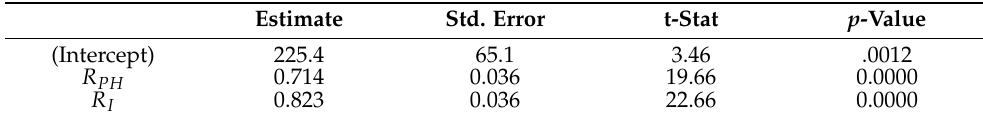
Table 7. Linear Regression Model for the maximum HP [ kW ] values.